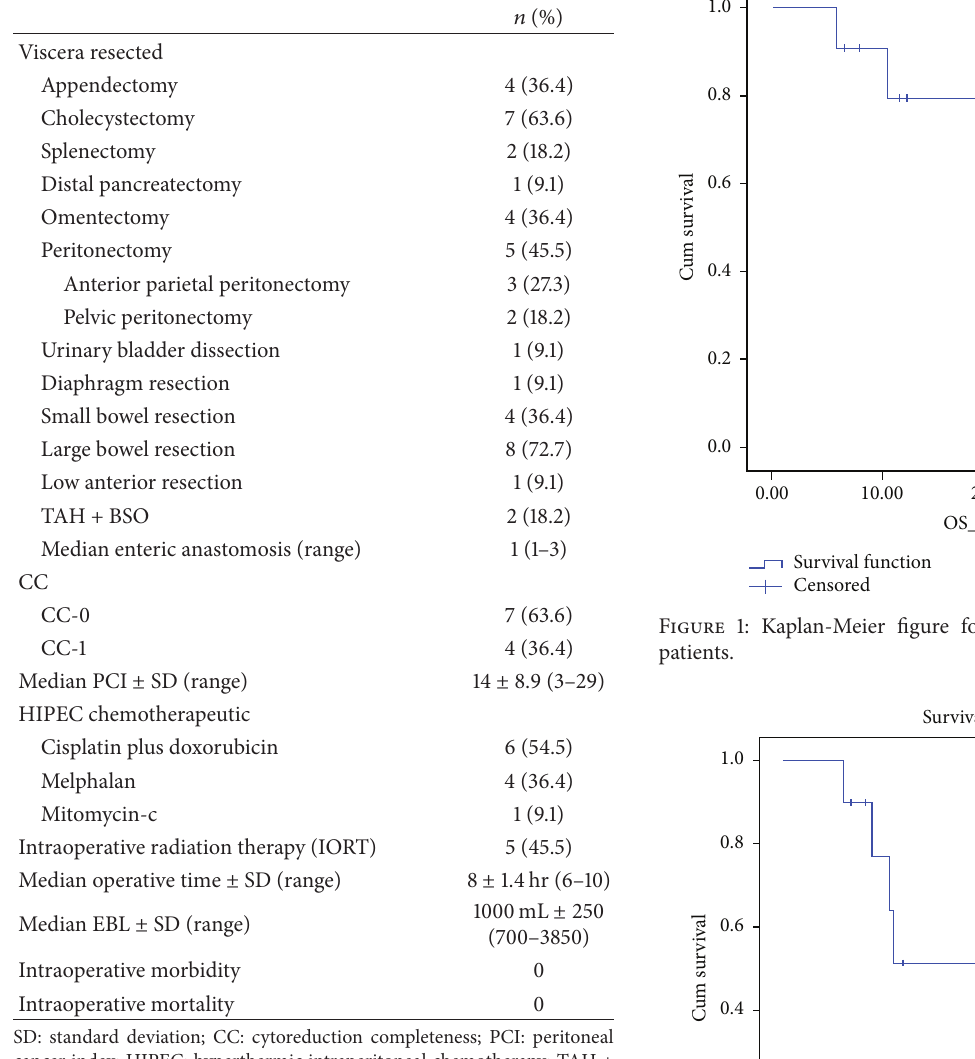
Table 2: Operative details of CRS plus HIPEC.